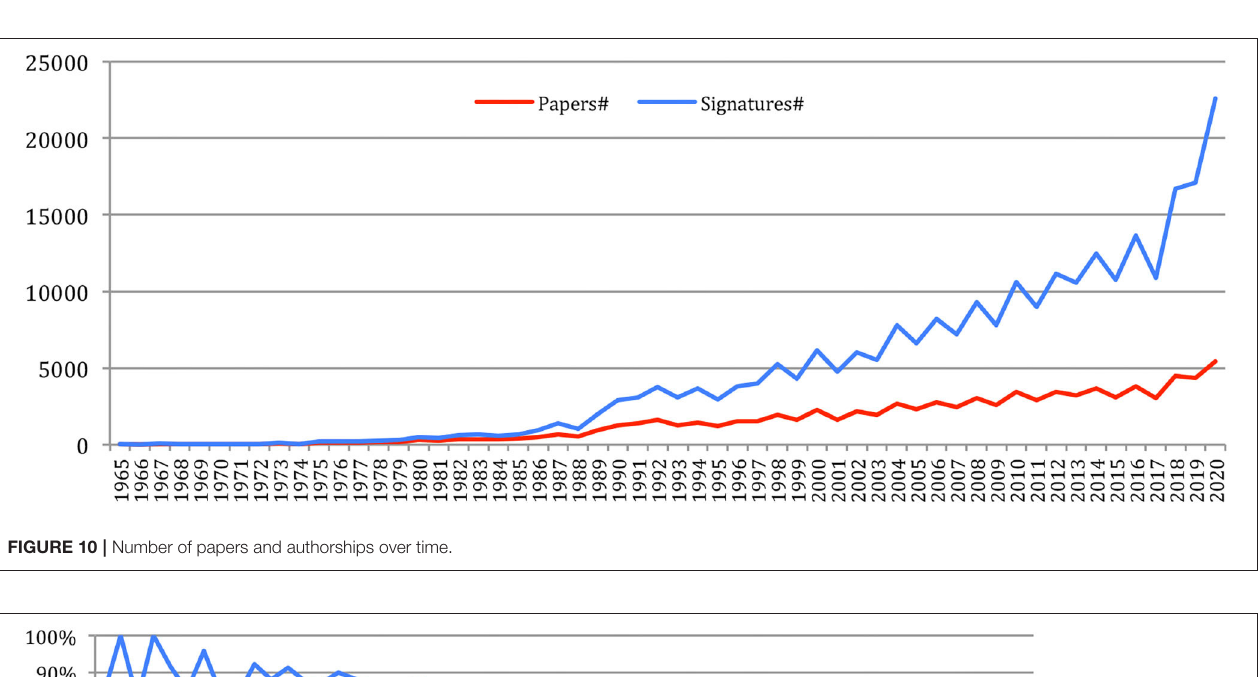
FIGURE 9 | Author redundancy across the sources in 2020 (red) and difference with 2015 (blue).